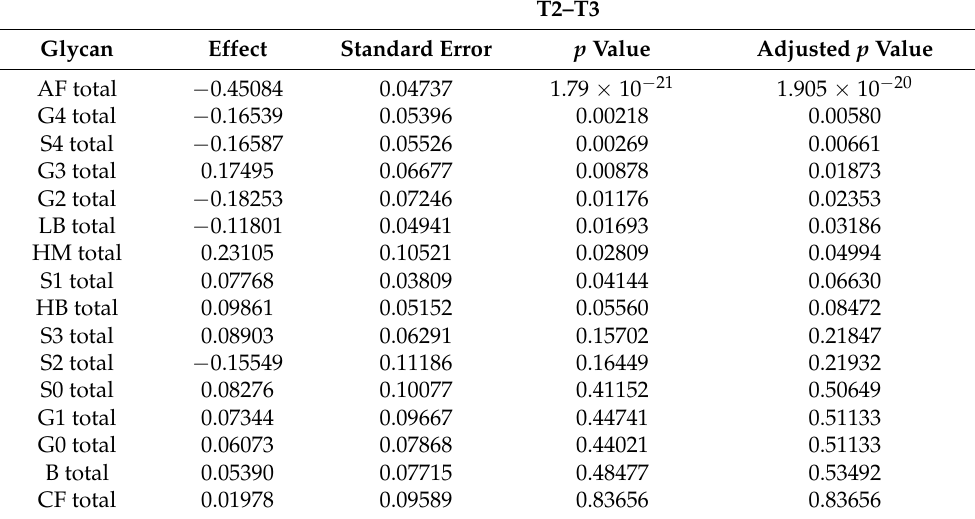
Table 2. Changes in plasma N-glycome composition in the second time period (T2–T3) after meta- analysis. Seven glycan traits showed statistically significant changes in their levels after 6 months on different weight-maintenance diets (adjusted p -value < 0.05). AF—total glycans with antennary